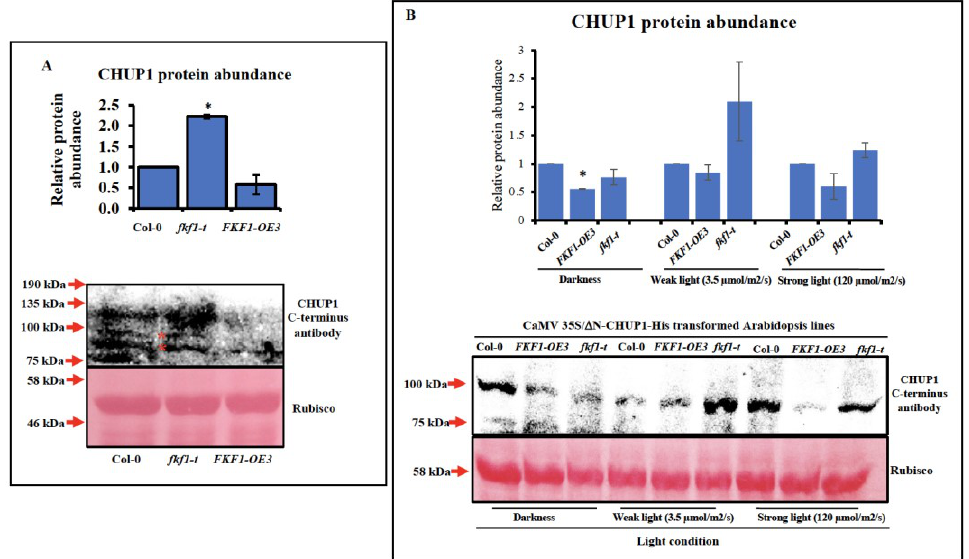
Figure 5. CHUP1 protein expression analysis. ( A ) Leaf samples of three-week-old Arabidopsis plants grown under long-day conditions (16 h light/8 h dark) were collected 12 h after dawn and used for Western blot analysis. The relative protein levels of CHUP1 were quantified using Ponceau S stained Rubisco large subunit (53 kDa) as an internal reference. The CHUP1 protein abundance of Col-0 was arbitrarily set as 1. The data are an average of two independent biological replicates. Error bars represent S.D. ( n = 2). One-way ANOVA, followed by Tukey and Dunnett multiple comparisons, was used to determine the statistically significant difference between Col-0 and other Arabidopsis lines under same light conditions and are labeled with * ( p < 0.05). Y-axis: % chloroplast. ( B ) Leaf samples of three-week-old Arabidopsis plants grown under long-day conditions (16 h light/8 h dark) were transferred to different light conditions, collected 12 h after dawn, and used for Western blot analysis. The relative protein levels of CHUP1 were quantified using Ponceau S stained Rubisco large subunit (53 kDa) as an internal reference. A 200 µg total protein sample was used for each line. The CHUP1 protein abundance of Col − 0 of each light condition was arbitrarily set as 1. The data are an average of two independent biological replicates. Error bars represent S.D. ( n = 2). One-way ANOVA followed, by Tukey and Dunnett multiple comparisons, was used to determine the statistically significant difference between Col − 0 and other Arabidopsis lines under the same light conditions; they are labeled with * ( p < 0.05). Y-axes: % chloroplast. * Represent significance.